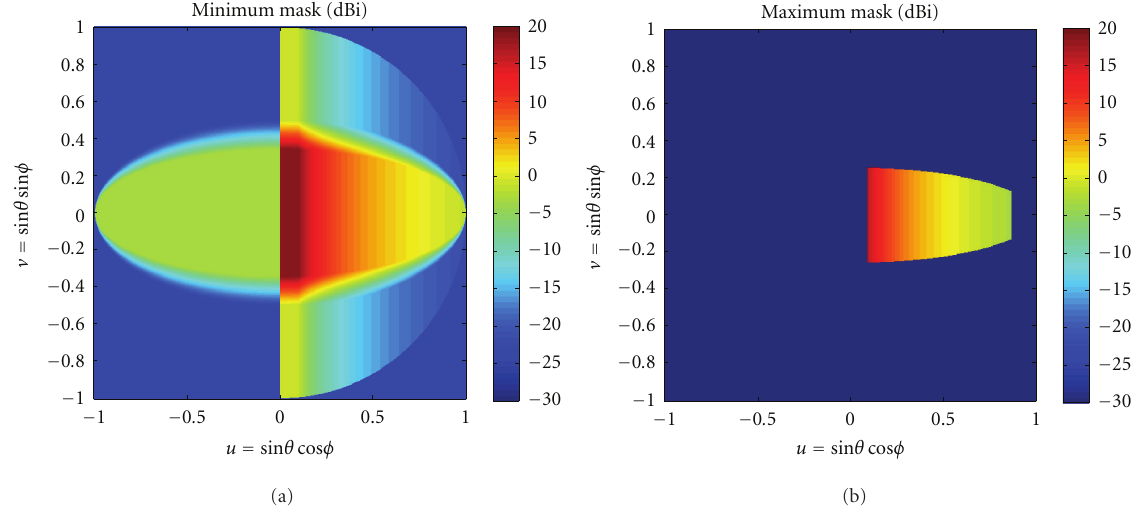
Figure 3: Pattern requirements G M ( r t ) (a) and G m ( r t ) (b), in all the considered directions r t = ( u , v )